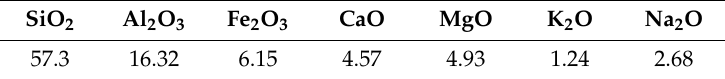
Table 5. Ash compositions (wt. %) of RAW coal.